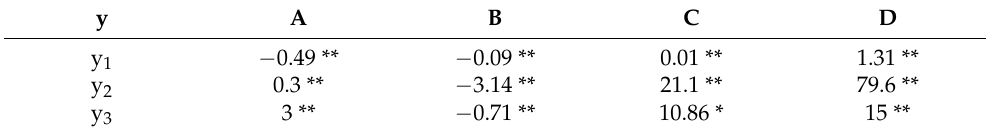
Table 7. The correlation coefficient of the regression